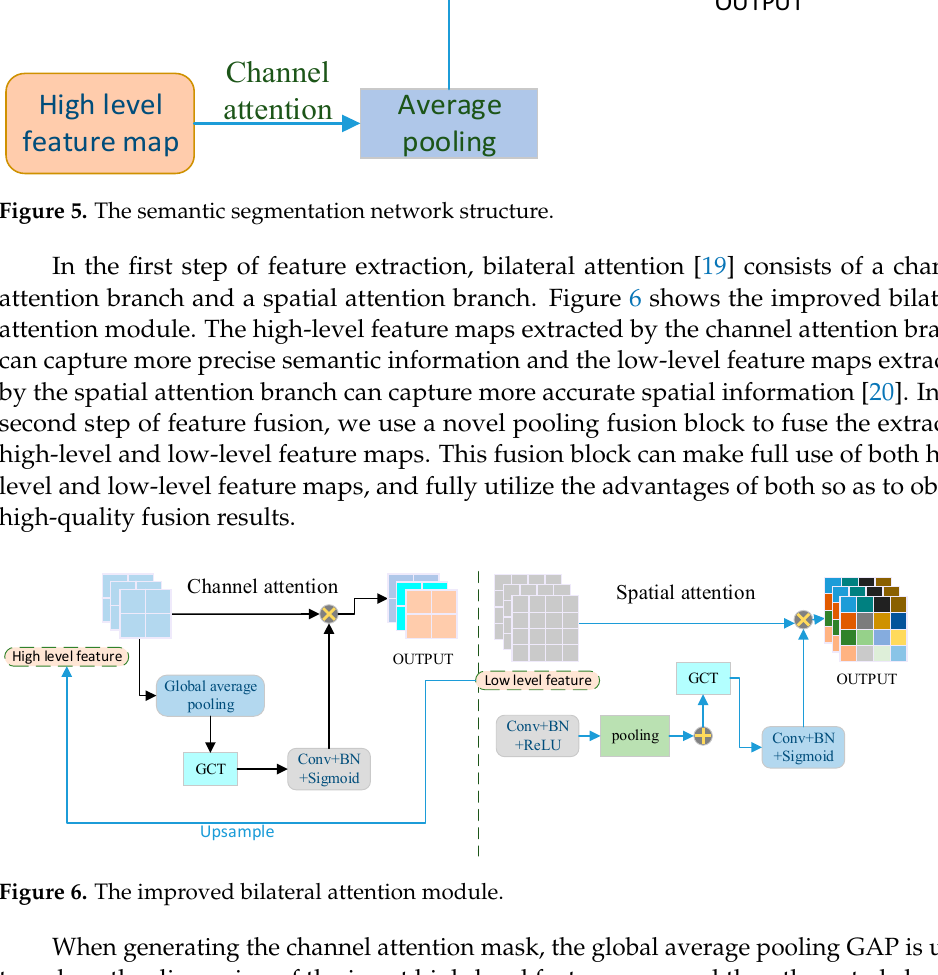
Figure 6. The improved bilateral attention module .